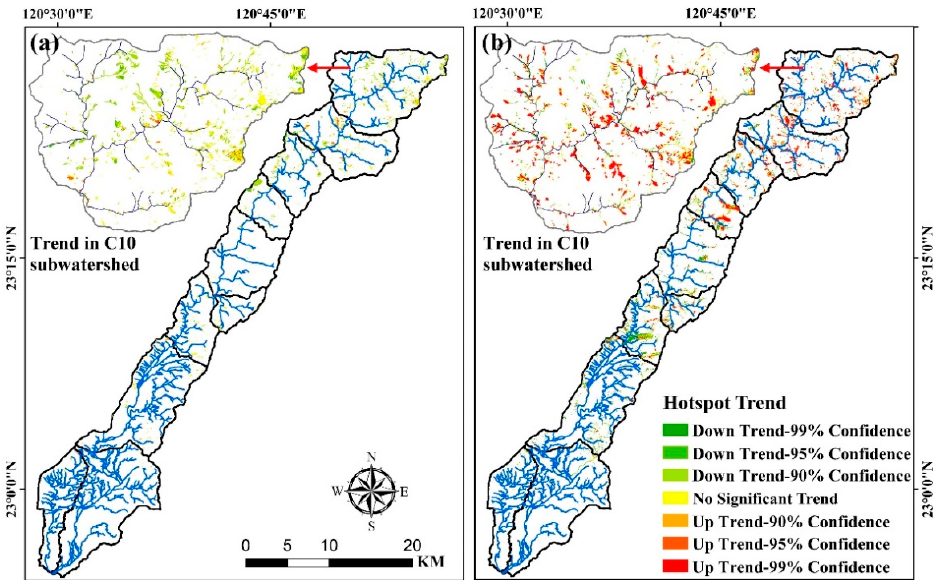
Figure 8. The spatial clustering distributions of landslides in 1999–2008 ( a ) and 2008–2017 ( b ) as assessed by using the Mann–Kendall trend test in the Chishan river watershed. The upper-left plots show the spatial clustering distribution of landslides in the C10 subwatershed in 1999–2008 ( a ) and 2008–2017 ( b ).